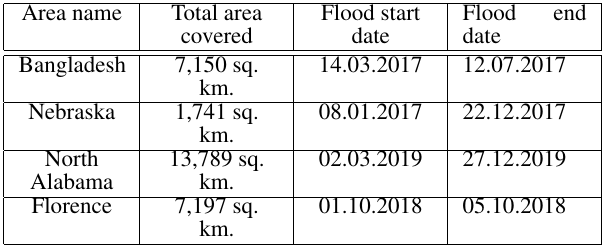
Table 1. Table showing the different flood events covered in the dataset